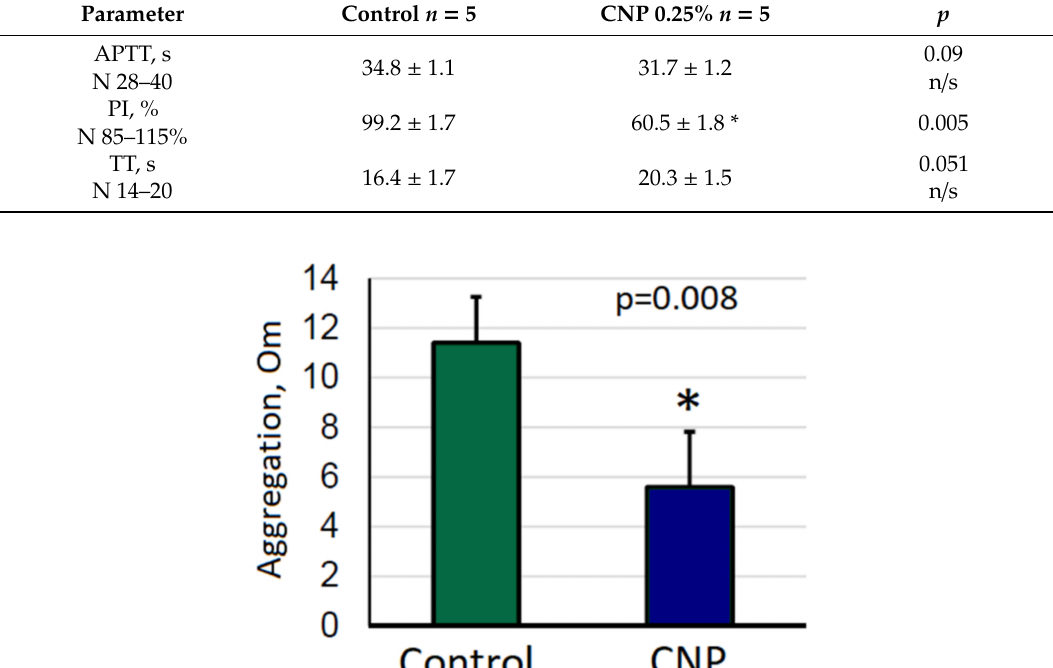
Table 1. Indicators of coagulation hemostasis following addition of chitosan nanoparticles to human plasma. Mean ± standard error. n / s – non-significant data. * – p < 0.05 compared to control.